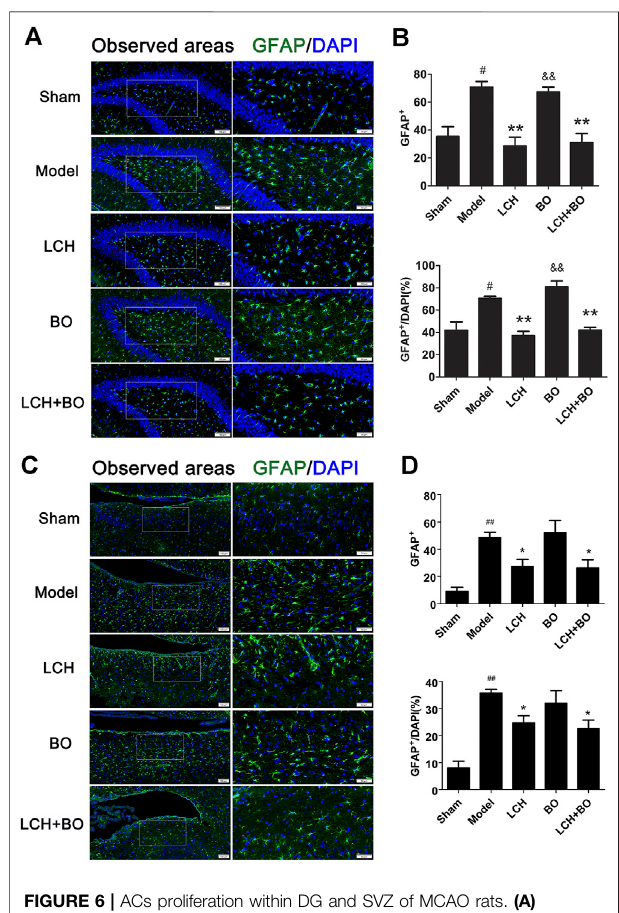
FIGURE 6 | ACs proliferation within DG and SVZ of MCAO rats. (A) Representative immunostaining images of GFAP in the DG area. (B) The results of GFAP + cells and GFAP + /DAPI in the DG area ( n (cid:1) 3). (C) Representative immunostaining images of GFAP in the SVZ area. (D) The results of GFAP + cellsand GFAP + /DAPI in theSVZ area ( n (cid:1) 3). # p < 0.05, ## p < 0.01 compared to the sham group; * p < 0.05, ** p < 0.01 compared to the model group; & p < 0.05, && p < 0.01 compared to the LCH + BO